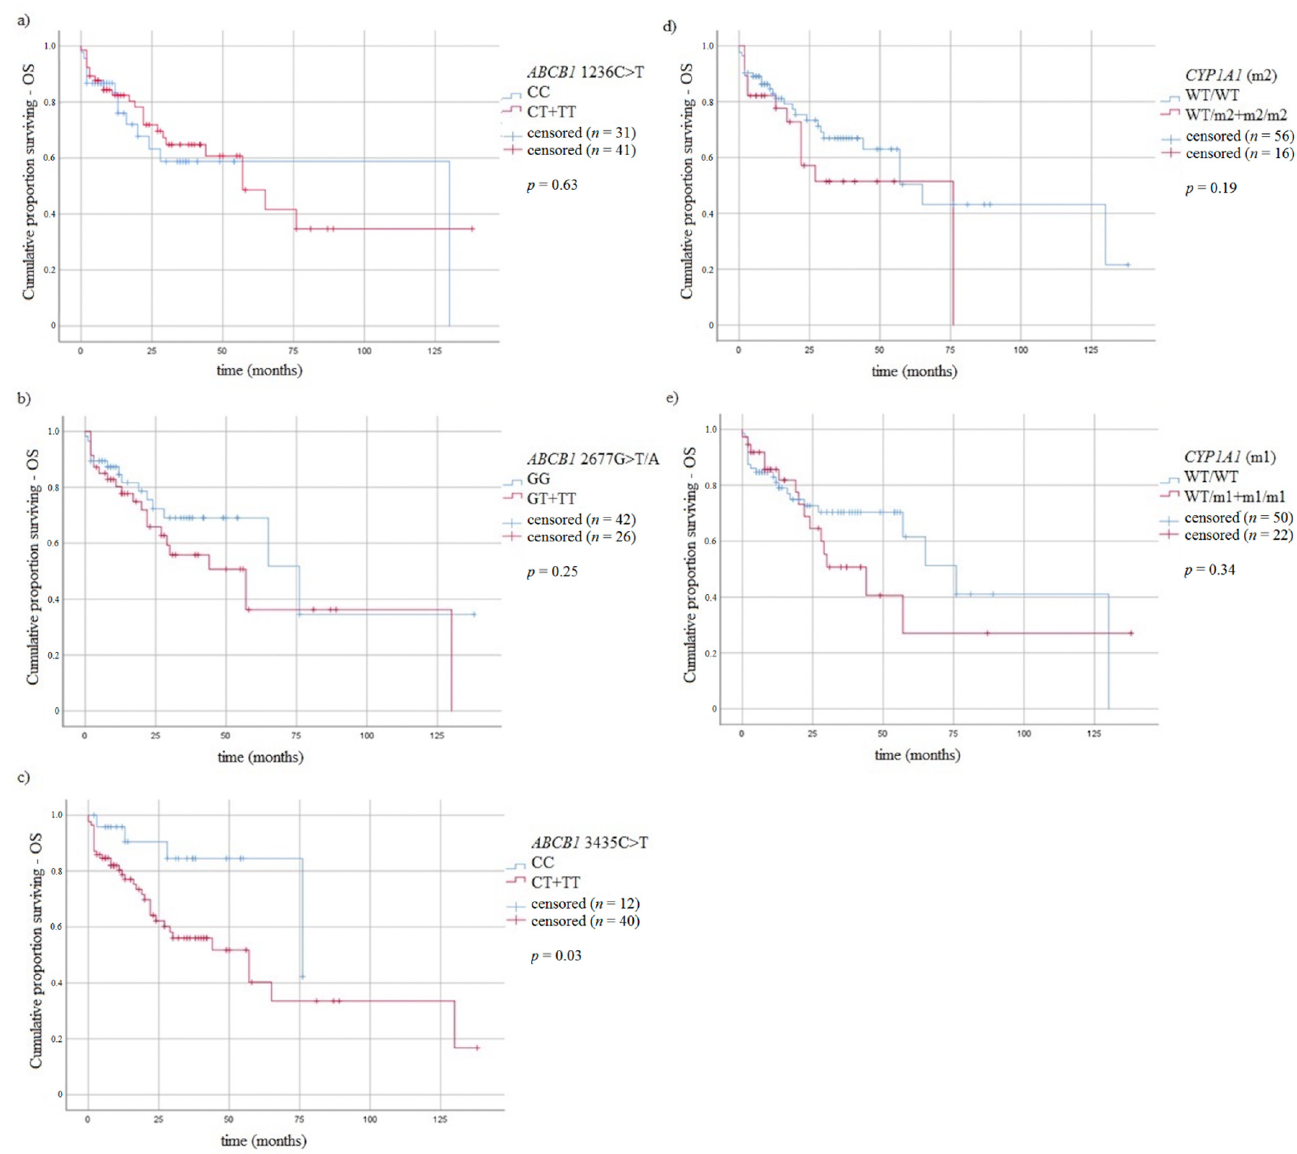
Figure 3. Kaplan ‐ Meier analysis of OS in MM patients with ( a ) ABCB1 1236C > T genotypes, log ‐ rank test p = 0.63; ( b ) Figure 3. Kaplan-Meier analysis of OS in MM patients with ( a ) ABCB1 1236C > T genotypes, log-rank test p = 0.63; ( b ) ABCB1 2677G > T/A genotypes, log ‐ rank test p = 0.25; ( c ) ABCB1 3435C > T, log ‐ rank test p = 0.03; ( d ) CYP1A1 4889A > G ABCB1 2677G > T/A genotypes, log-rank test p = 0.25; ( c ) ABCB1 3435C > T, log-rank test p = 0.03; ( d ) CYP1A1 4889A > G genotypes log ‐ rank test p = 0.19; ( e ) CYP1A1 6235T > C genotypes, log ‐ rank test p = 0.34. genotypes log-rank test p = 0.19; ( e ) CYP1A1 6235T > C genotypes, log-rank test p =